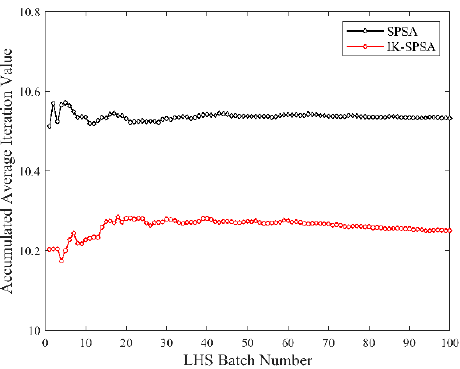
Figure 23. Accumulated average iteration final value distribution at same initial point.